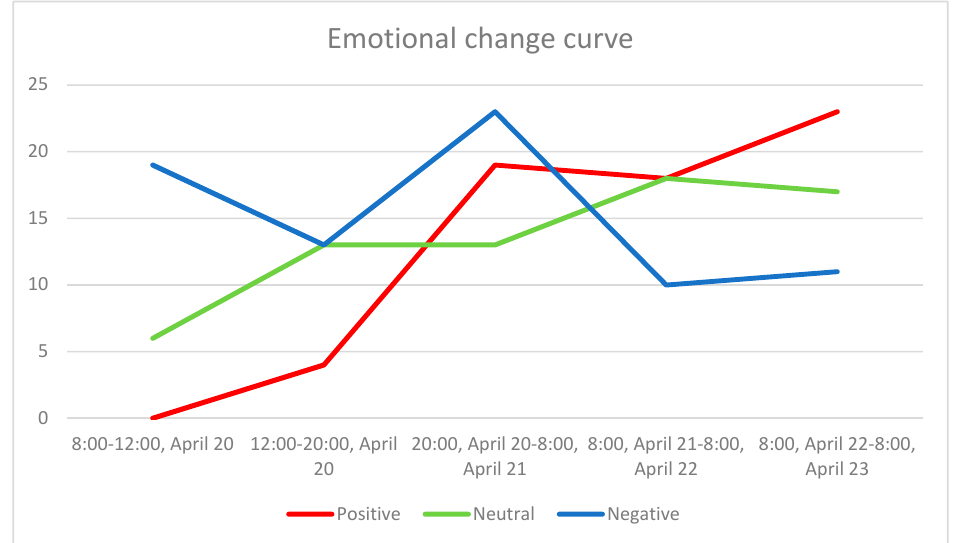
Figure 6. Changes in different emotion categories in data volume for different periods of time.